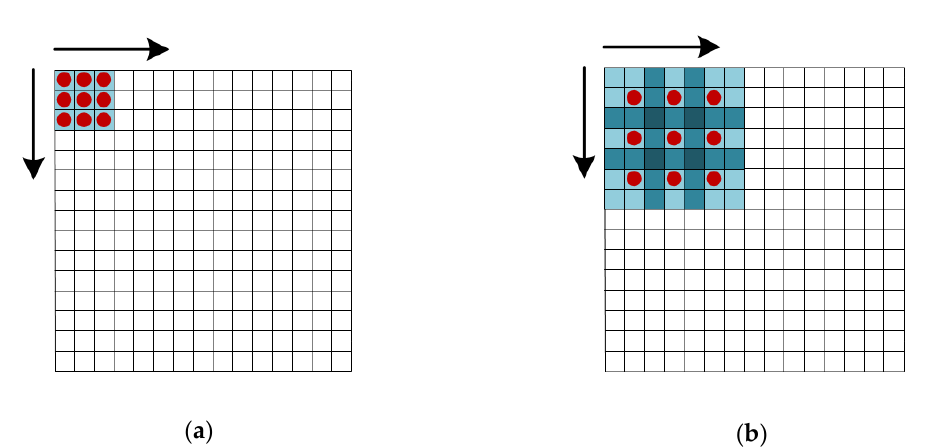
Figure 4. Convolution kernels for ( a ) standard kernel, which has a receptive filed of 3 × 3, and ( b ) dilated kernel with dilation rate = 2, and its receptive field is 7 ×